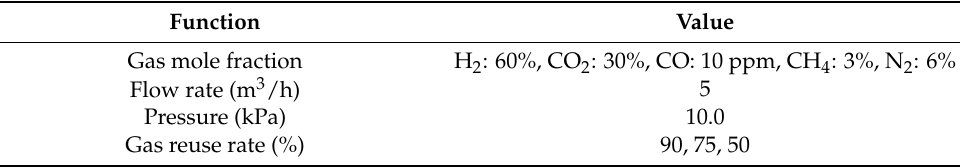
Table 1. Operating